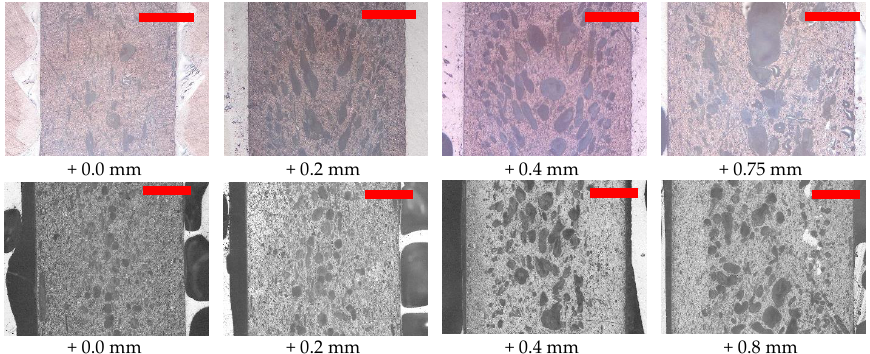
Figure 10. Foam structure of physically ( top row ; N06_T60) and chemically ( bottom row ; CB_film) foamed specimens of PPWood at different mould opening gaps. Dark spots in the samples represent pores, i.e., voids. Bright spots represent pores filled with resin from the sample preparation. The red bars represent 1 mm.